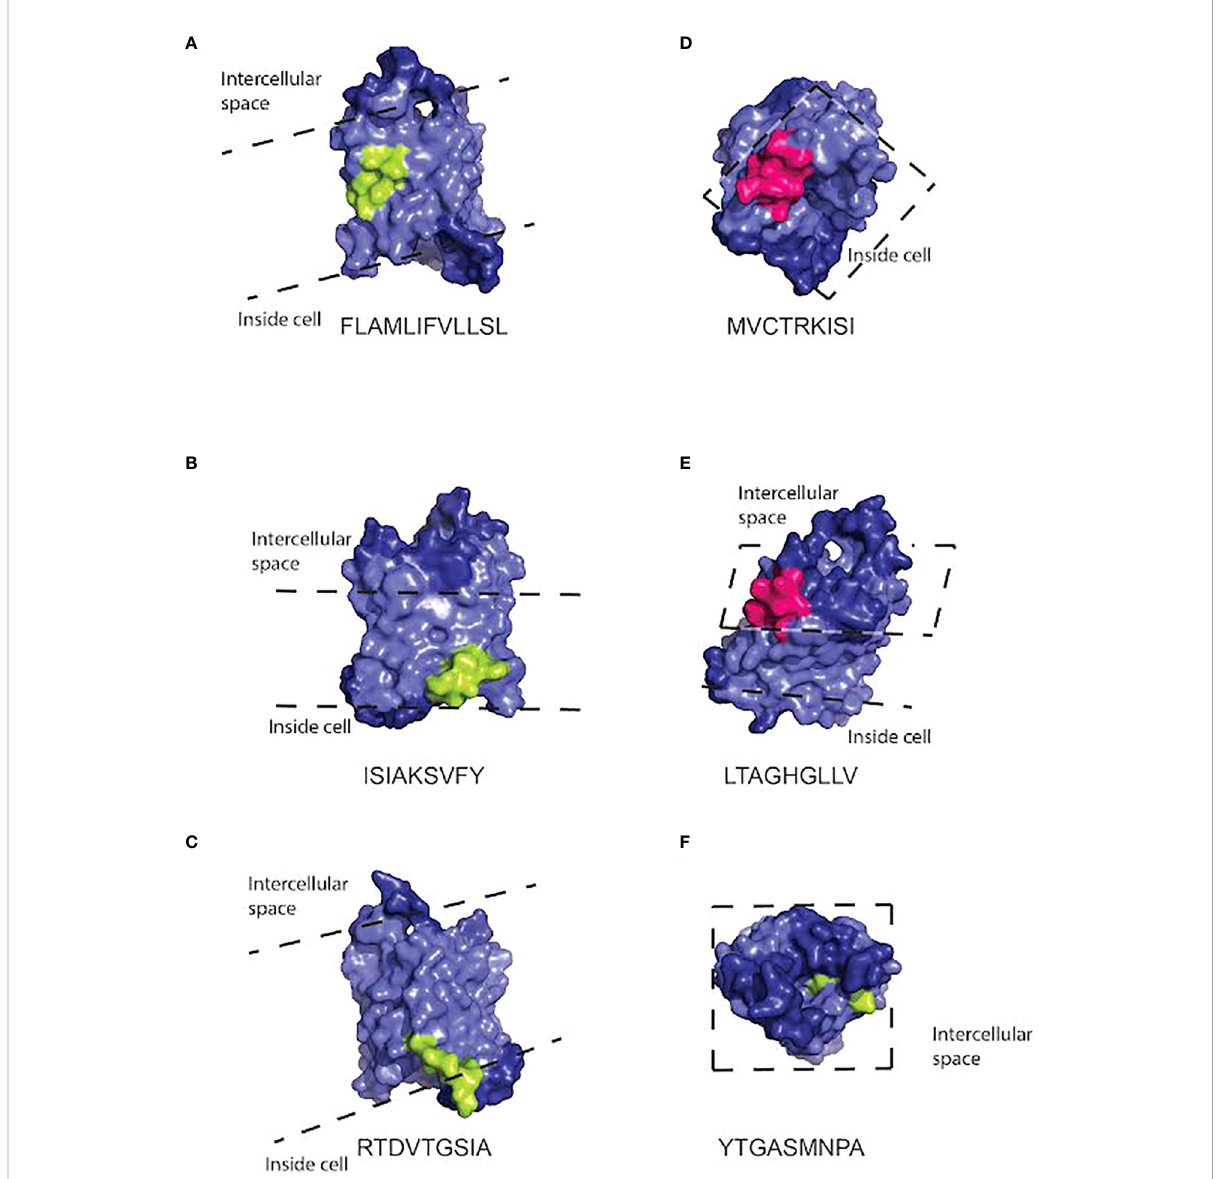
FIGURE 4 Three dimensional space- fi lling cartoon of the AQP4 molecule positioned so that peptides capable of binding HLA class I molecules in the haplotype (either A*0101, B*0801, or C*0701) are visible. The pale blue section of the molecule indicates the intramembrane portion. Dashed lines indicate the approximate position of the extracellular and intracellular surfaces of the cell membrane. Peptides that bind HLA class I molecules strongly are indicated in light green. Promiscuous binders are indicated in pink. Peptide sequences and the HLA molecules binding to them are listed under each model. Peptide sequences: (A) FLAMLIFVLLSL (B) ISIAKSVFY (C) RTDVTGSIA (D) MVCTRKISI (E) LTAGHGLLV (F)